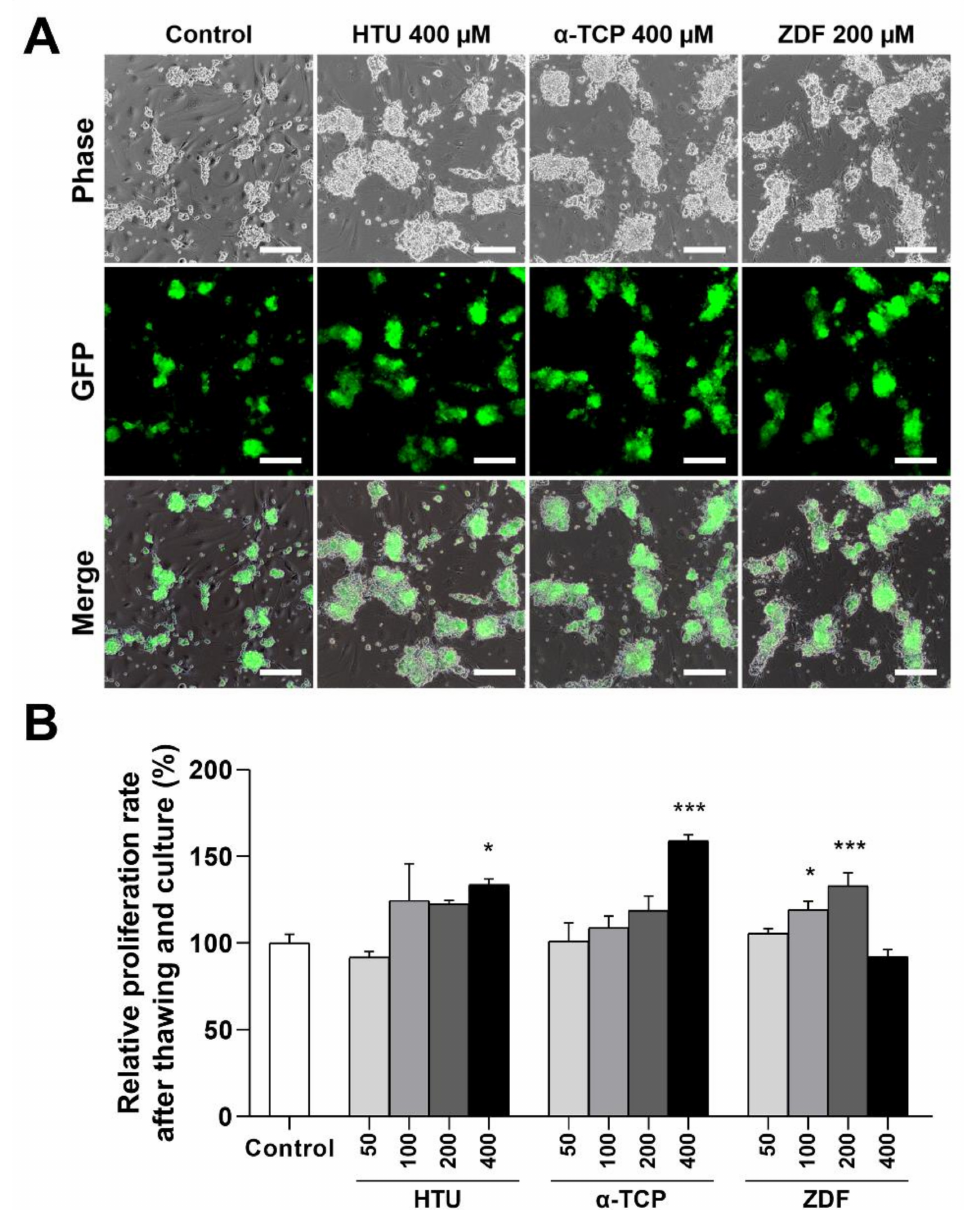
Figure 1. Effects of post-thaw recovery with antioxidant or apoptosis inhibitor supplementation on frozen germ cells. ( A ) Bright/dark-field images of GFP + germ cells after post-thaw recovery for 12 h followed by in vitro culture for one week. Scale bars = 100 µ m (10 × ). ( B ) Relative proliferation rate after post-thaw recovery with antioxidant or apoptosis inhibitor supplementation at different concentrations. The cells in the control group received no treatment after cryo-thawing. The values are expressed as the mean ± SEM ( n = 5). Statistical analyses were performed using one-way ANOVA coupled with Dunnett’s post-hoc test. Asterisks indicate statistical significance at p < 0.05 (*) and p < 0.001 (***). HTU, Hypotaurine; α -TCP, α -tocopherol; ZDF,